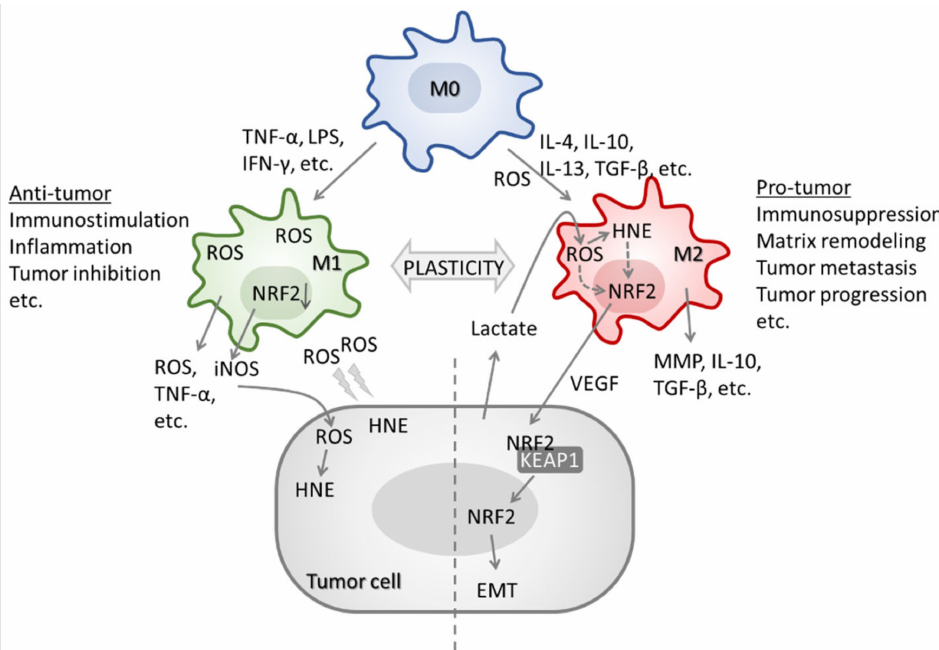
Figure 3. The involvement of cytokines, ROS, HNE, and NRF2 in TAM polarization. In response to TNF- α , LPS or IFN- γ , TAMs are differentiated into M1 phenotype. M1 TAMs express high levels of iNOS, ROS, and TNF- α promoting HNE, immunostimulation, inflammation, and inhibiting tumor growth. In contrast, in response to IL-4, IL-10, IL-13 or TGF- β , TAMs are polarized to M2 phenotype. Although M2 TAMs have lower ROS compared to M1, ROS are essential for NRF2 activation and M2 polarization. M2 TAMs produce TGF- β , MMP, IL-10, and VEGF promoting matrix remodeling, EMT, tumor growth, and